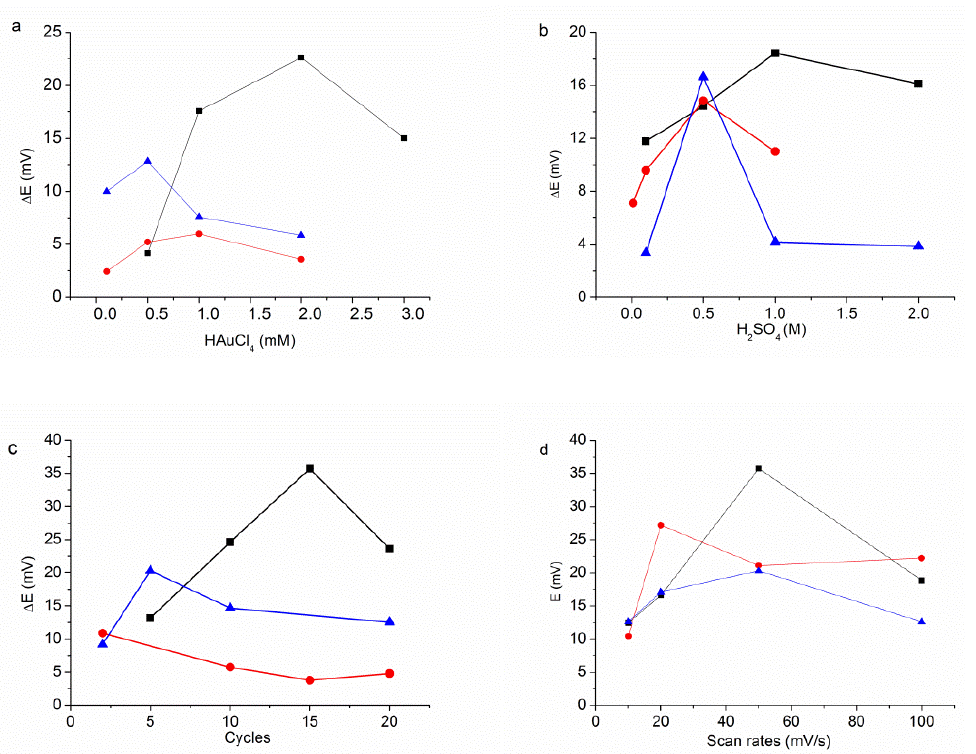
Figure 3. Effect of ( a ) HAuCl 4 concentration, ( b ) H 2 SO 4 concentration, ( c ) scan cycles and ( d ) scan rates on the response of AuNPs modified GC electrode toward 10 μ g mL − 1 of BSA ( ▲ ), GOx ( ● ) and casein ( ■ ) adsorption. The default condition is 1 mM HAuCl 4 , 1 M H 2 SO 4 , 10 scan cycles, and 50 mV/s scan rate. The condition for maximizing signal response was determined using Design of Experiments (DOE) in supporting information.